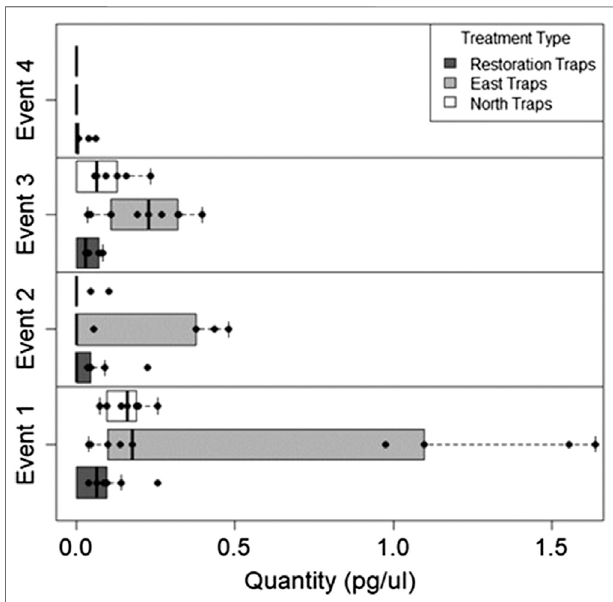
FIGURE5| Thequantityof Bouteloua genuseDNAcollectedforallthree trap locations over four sampling Events. Bouteloua genus eDNA concentrations generally decreased over time with notable spikes after the restoration treatments.